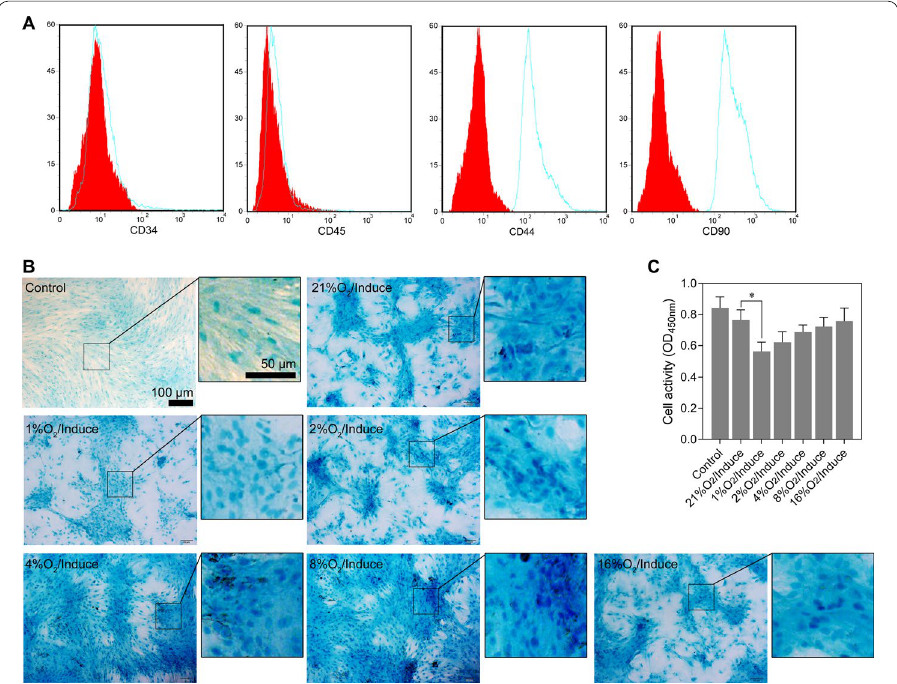
Fig. 1 Hypoxia influenced the chondrogenic differentiation of rMSCs. (A) Isolated rMSCs were identified by flow cytometry. B The rMSCs were cultured with MCDM under hypoxic conditions (1, 2, 4, 4 8, 16, 21% O 2 ) for 14 days. Proteoglycan deposition was shown by Alcian blue staining assays. C Cell activity was showed by Cell Counting Kit-8. * p <